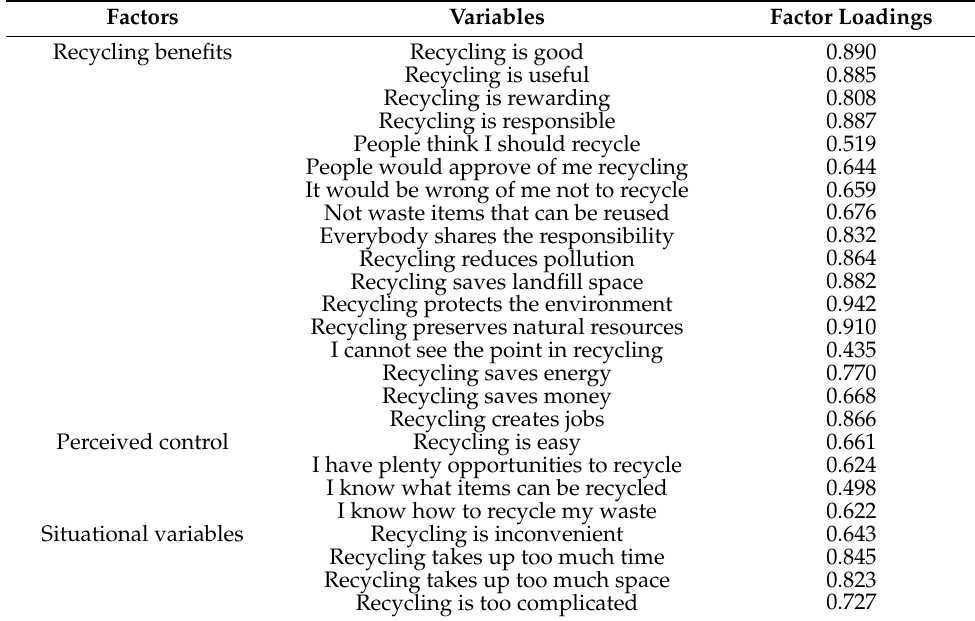
Table 12. Factor analysis and factor loadings of each